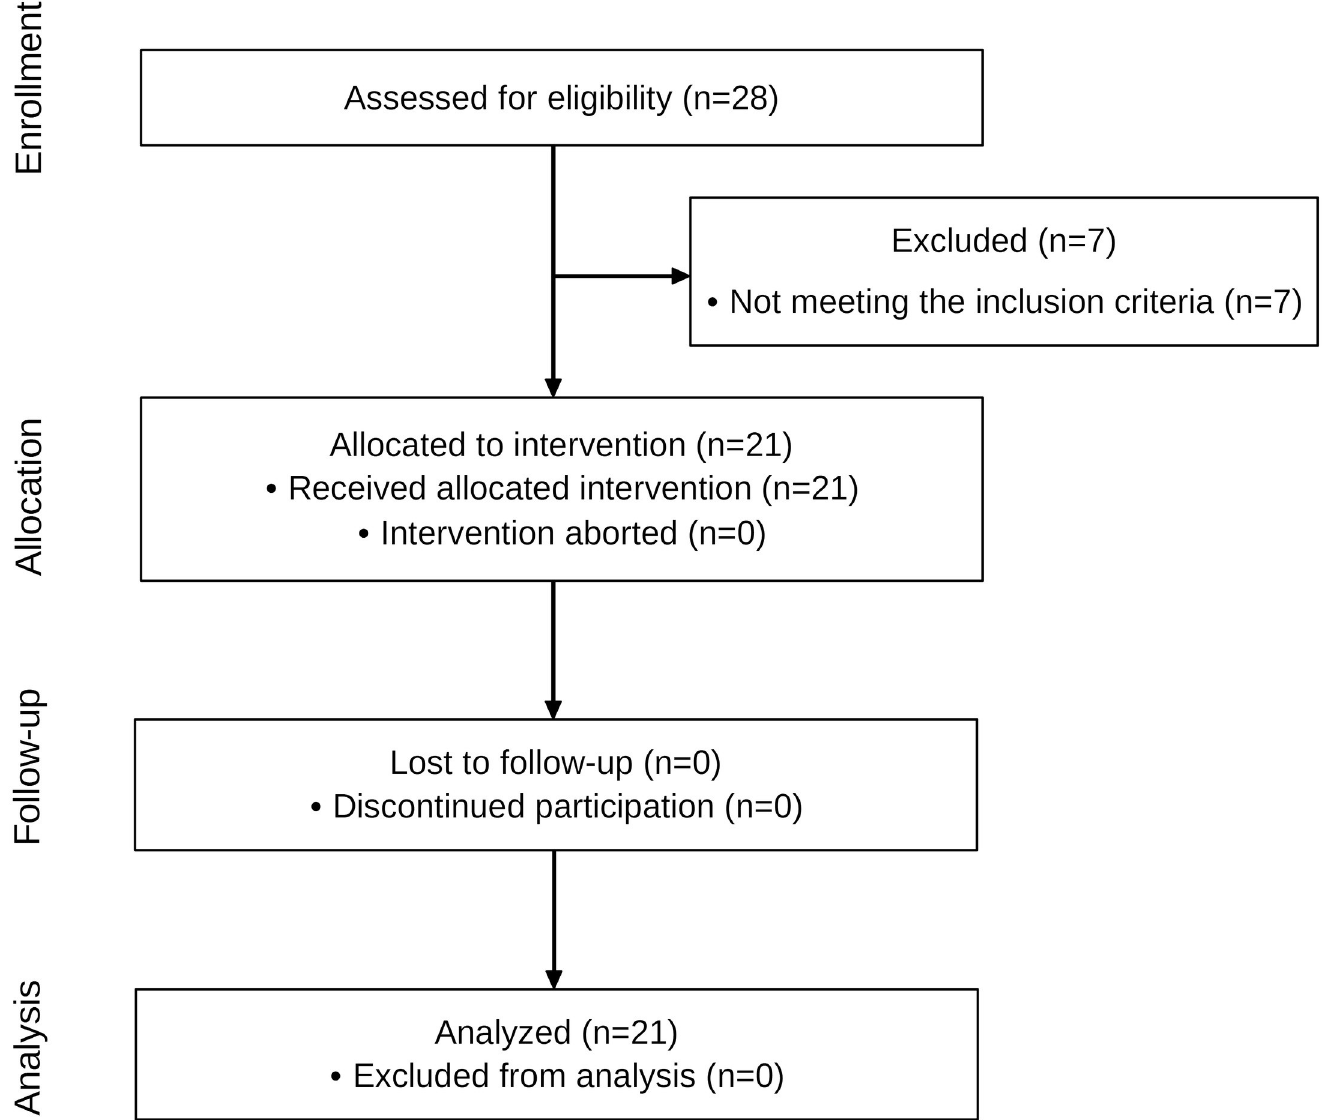
Fig 1. Flow diagram of the